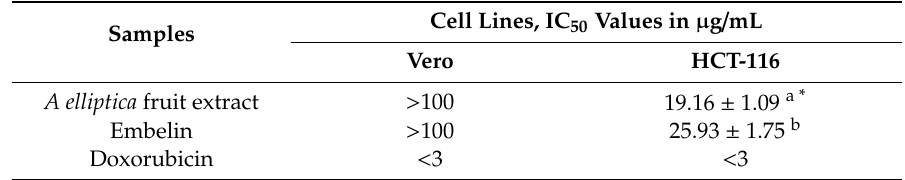
Figure 3. The anti-proliferative e ff ects of A. elliptica fruit extract ( A ) and embelin ( B ) against HCT-116 cells after 48 h of incubation. Table 1. The anti-proliferative e ff ects of A. elliptica fruit extract, embelin, and doxorubicin toward HCT-116 and Vero cells as determined by a cell proliferation assay.